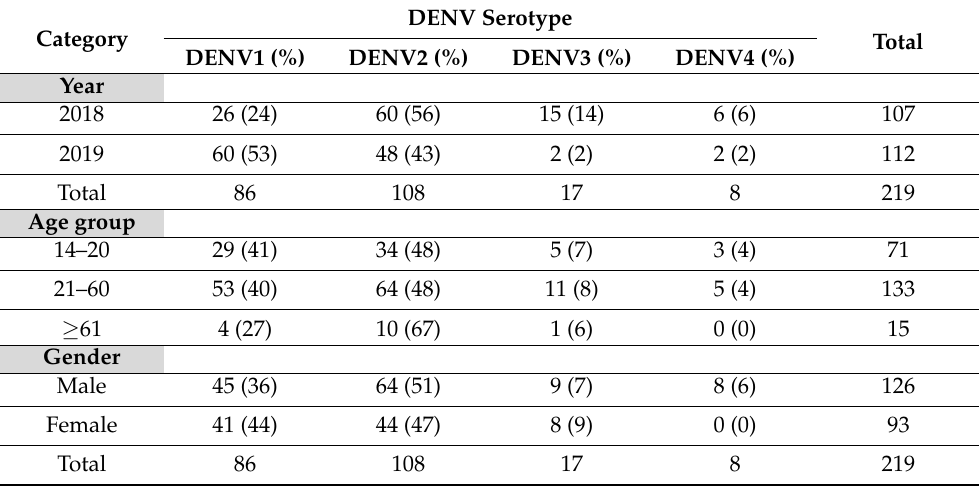
Table 1. DENV serotypes identified in the Jaffna district in relation to year, patient age group and